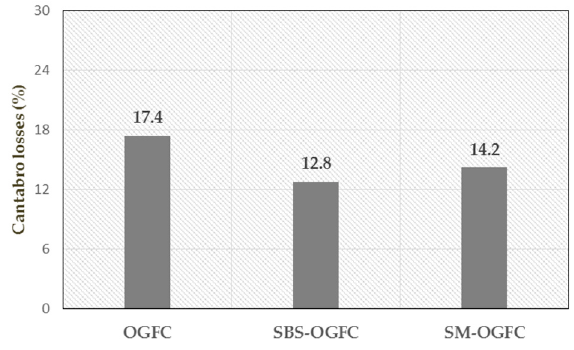
Figure 10. Cantabro losses of all OGFC mixtures.